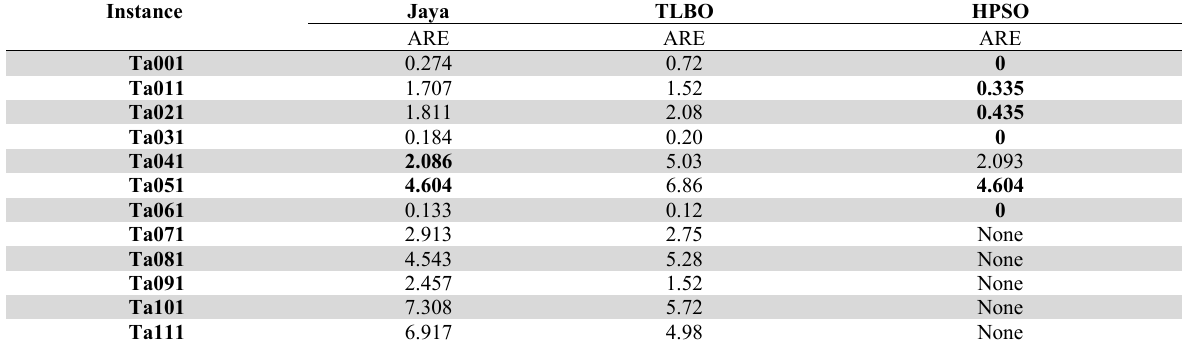
Comparisons of ARE values of HPSO, TLBO and Jaya. Bold indicate the best solution obtained among various